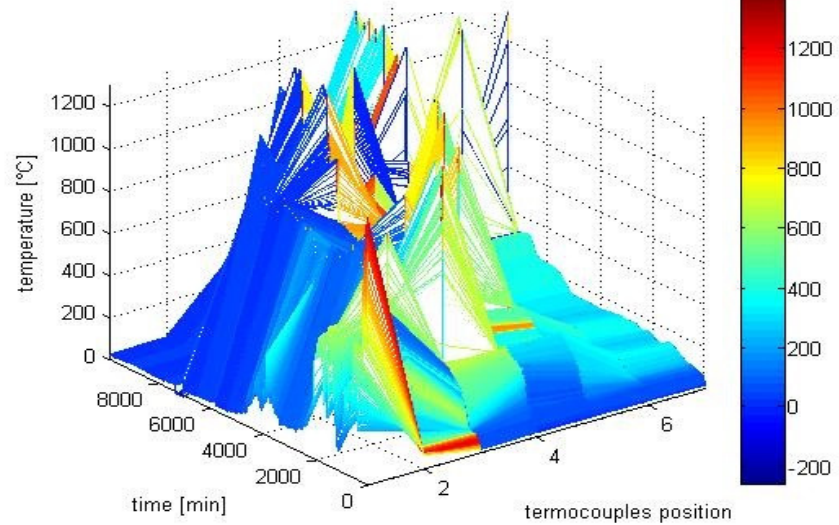
Figure 8. Time profile of the temperatures in the gasification channel along the length of the generator for the first experiment.